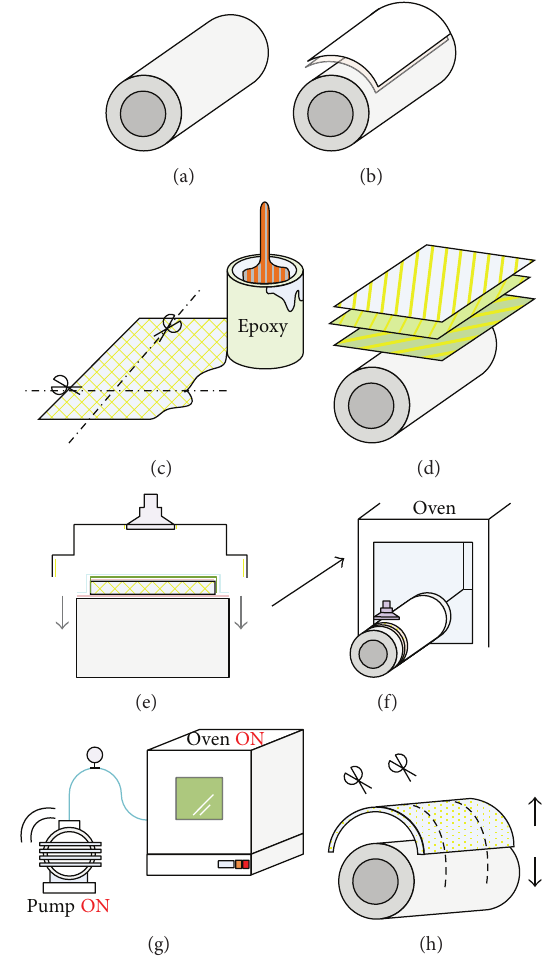
Figure 5: The fabrication process for the fiberglass